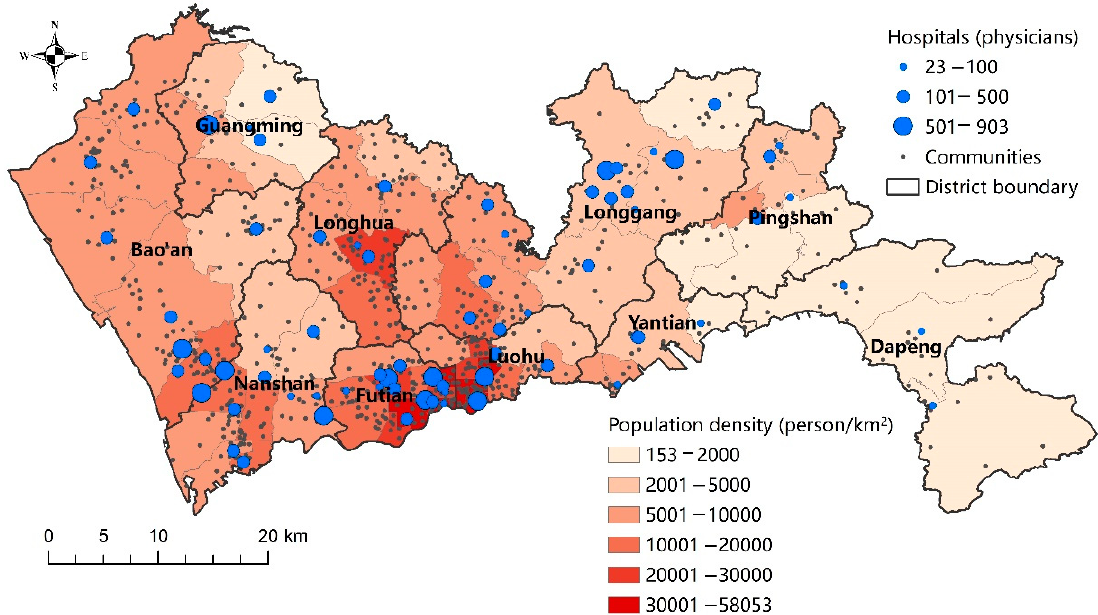
Figure 3. The distribution of hospitals and administrative divisions in